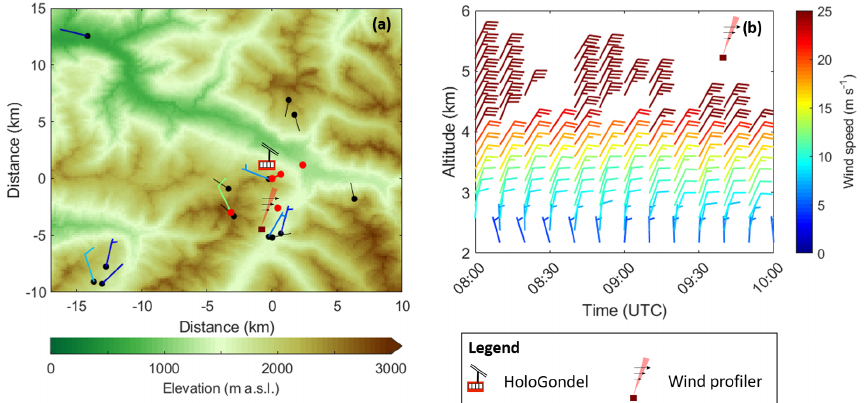
Figure 4. The wind direction and speed at different weather stations averaged between 08:00 and 10:00UTC in the Davos region are shown in (a) . The colors of the wind barbs show the wind speed according to the color bar, while stations with black lines only report wind direction. The wind profiler data, measured in Wolfgang, are shown in (b) . The elevation data were taken from the digital height model DHM25 of the Federal Office of Topography swisstopo: https://shop.swisstopo.admin.ch/de/products/height_models/dhm25200 (last